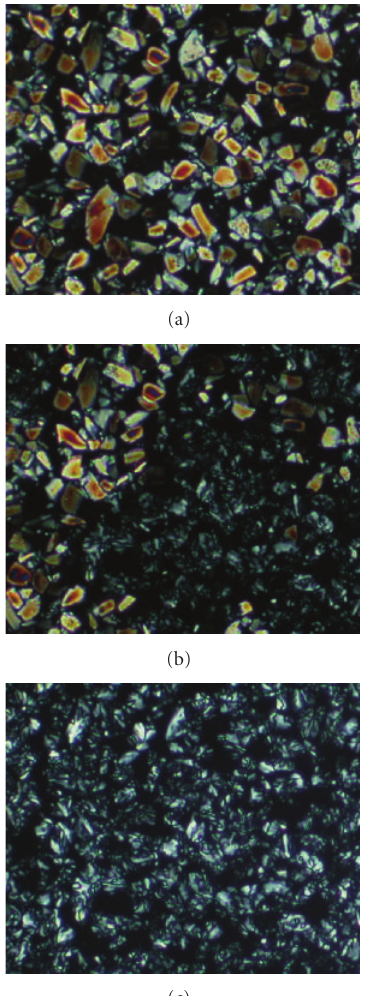
Figure 13: Polarized optical micrographs of cholesteryl acetate dispersed in UV15 taken during cooling from the isotropic phase at (a) 90.4 ◦ C, (b) 71.6 ◦ C, and (c) 25 ◦